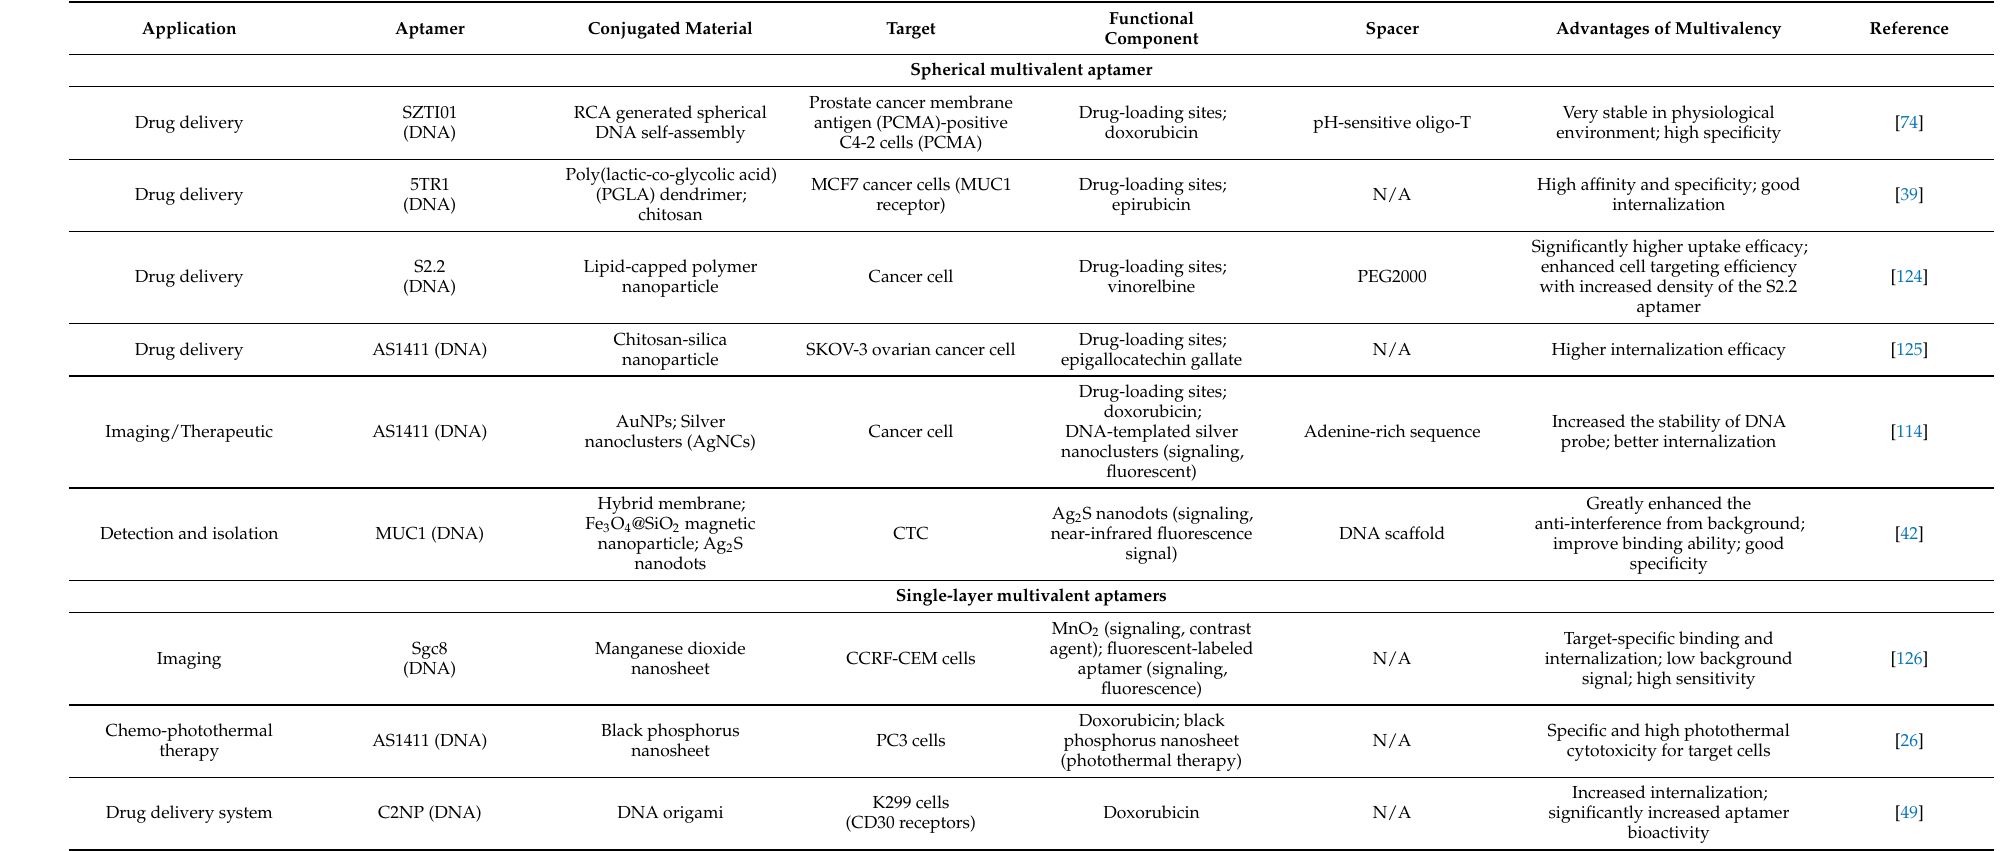
Table 1. A summary of recently published multivalent-aptamers-related